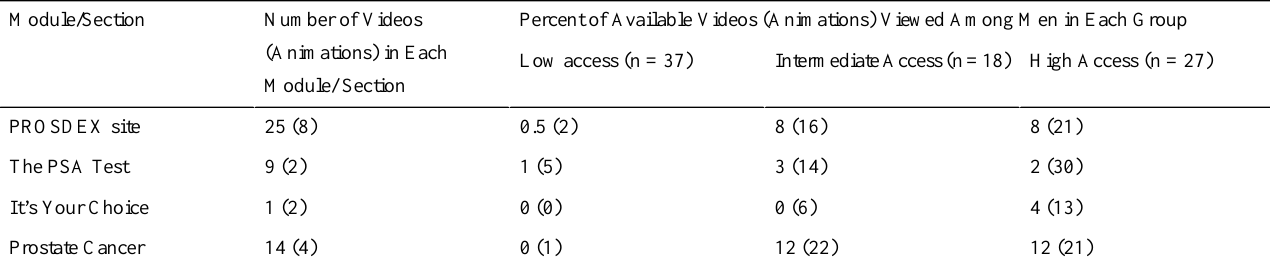
Table 3. A summary of participants’use of video clips and animations on Prosdex among men in the low, intermediate, and high access group Percent of Available Videos (Animations) Viewed Among Men in Each GroupNumber of